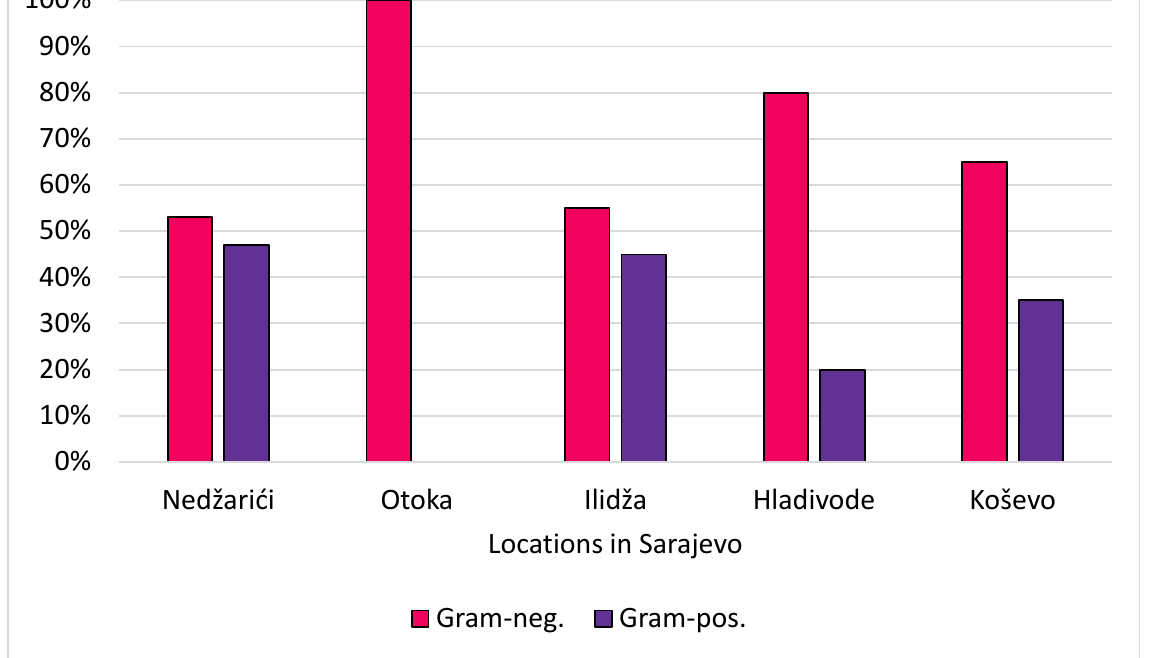
Figure 2. Percentage of gram-negative and gram-positive bacteria in